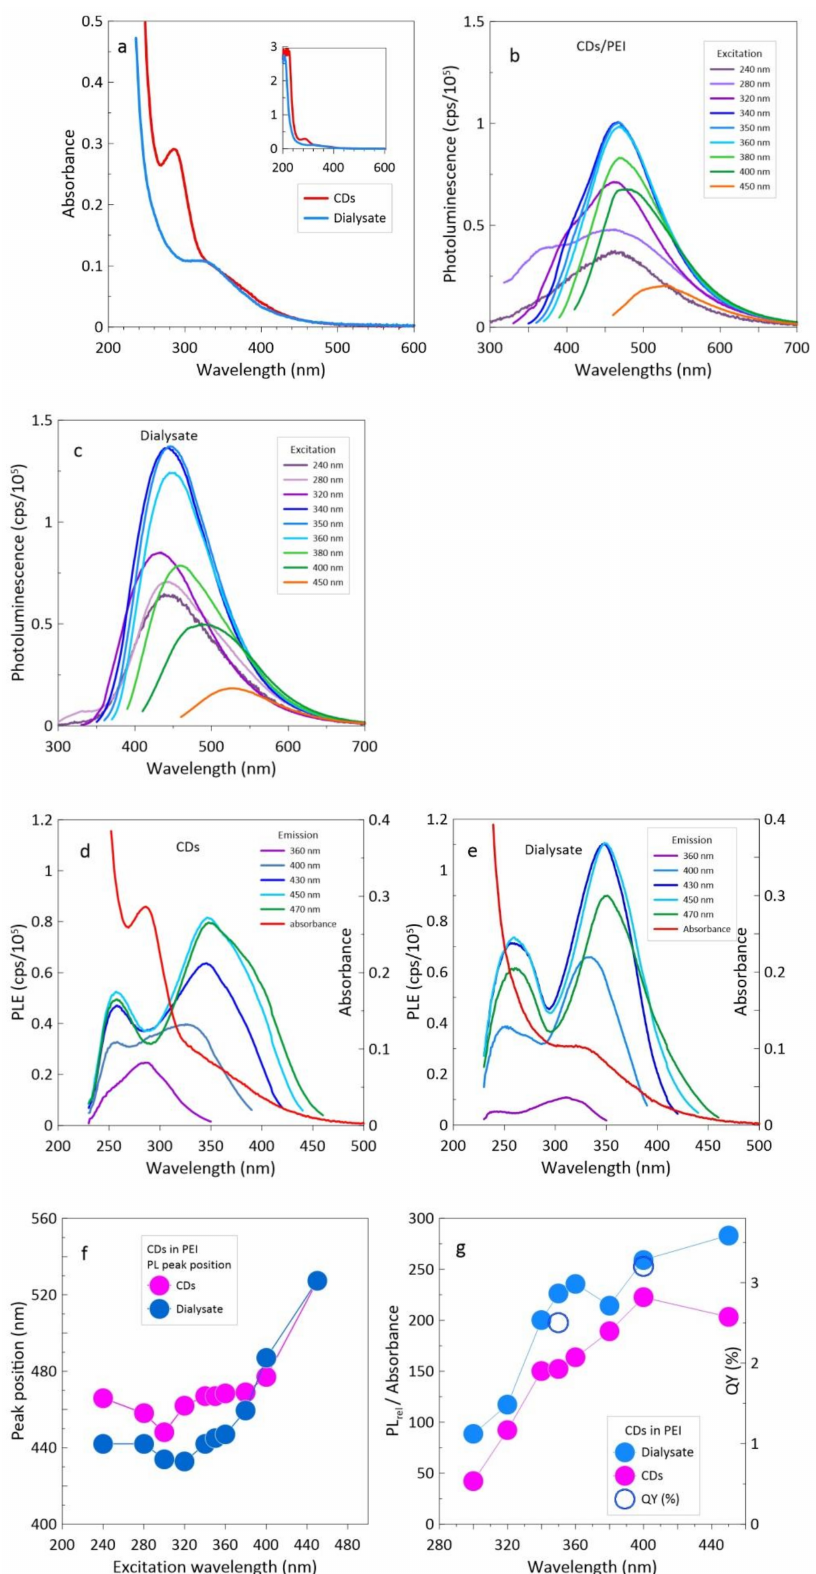
Figure 3. Optical properties of dialyzed CDs and dialysate: ( a ) absorbance; ( b ) PL of CDs; ( c ) PL of dialysate; ( d ) PL excitations scans of CDs; ( e ) PLE of dialysate; ( f ) PL peak position; and ( g ) ratio of integrated photoluminescence to absorbance